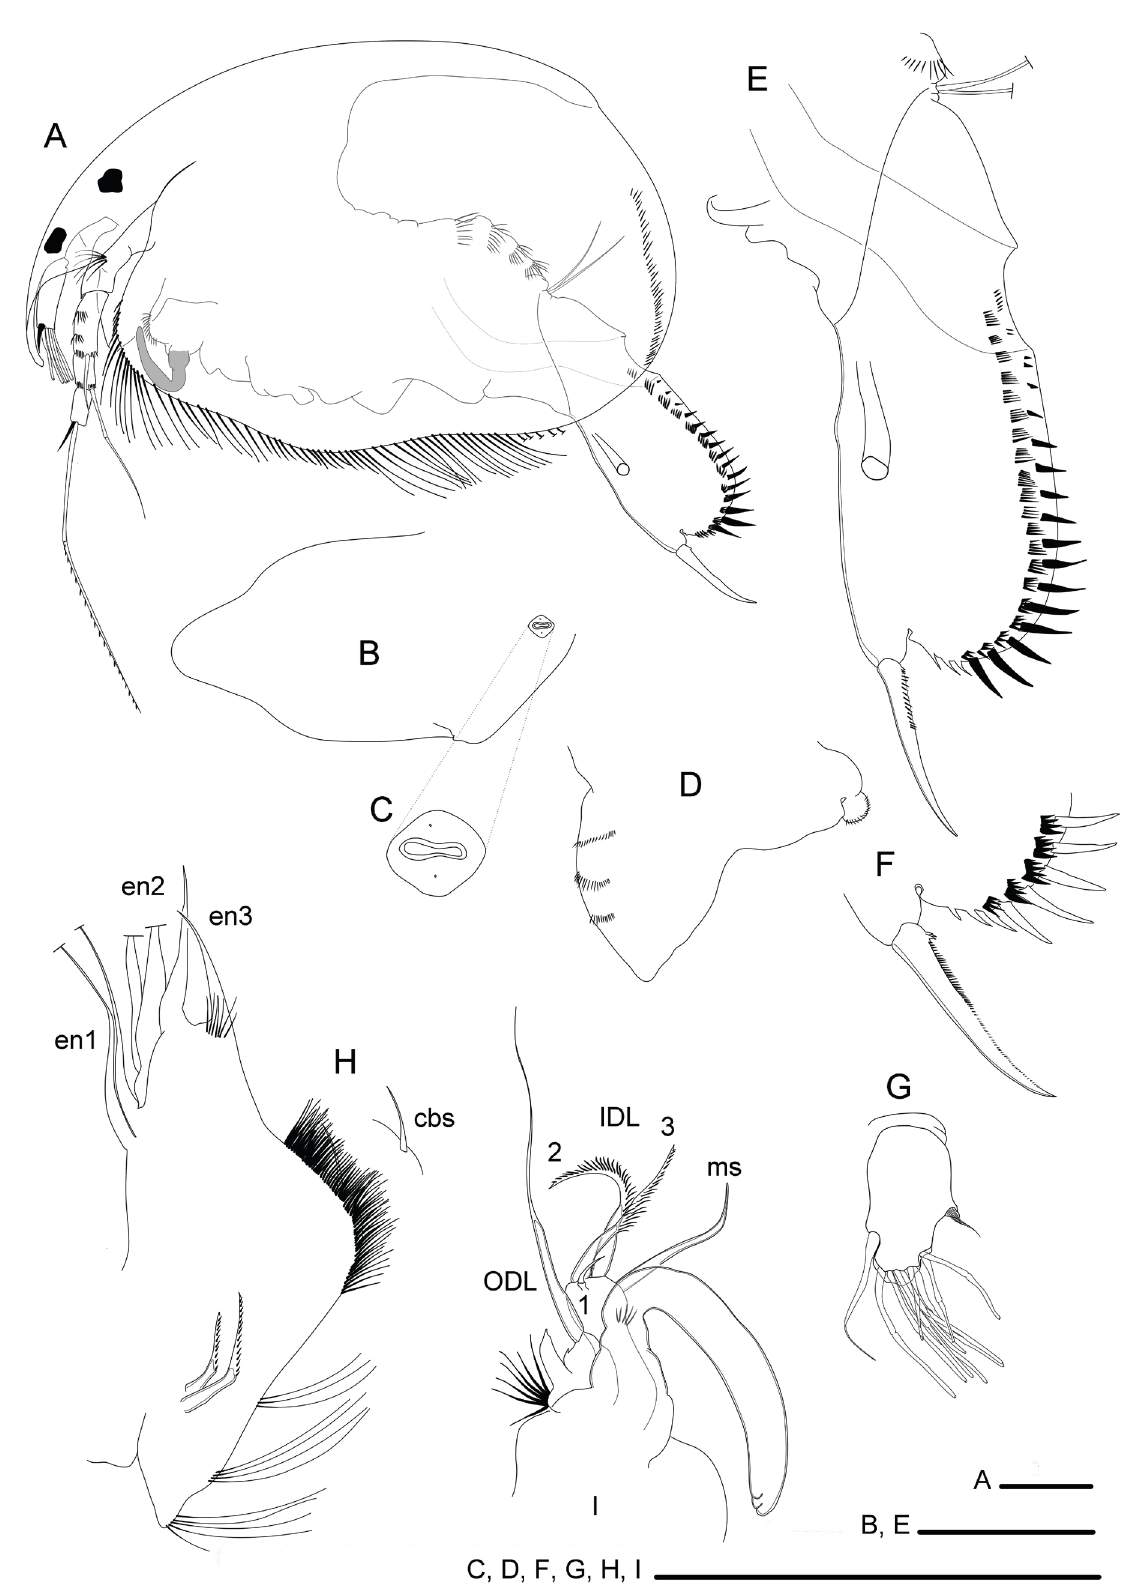
Figure 4. Adult male of Leydigiopsis ornata : A, Habitus ; B, Head Shield; C, main head pores; D, Labral keel; E, Postabdomen; F, idem , postabdominal claw; G, Antennule; H, First limb, endites (en) and copulatory brush seta (cbs); I, idem , copulatory hook, Inner Distal Lobe (IDL) and Outer Distal Lobe (ODL). Scale bars = 50